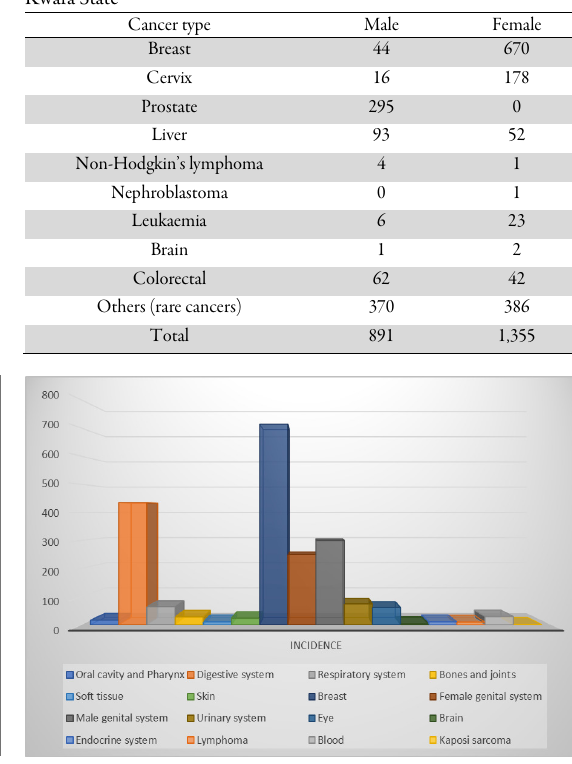
Fig. 1. Prevalence of cancer between 2007-2016 Fig. 2. Cancer incidence by various cancer sites from